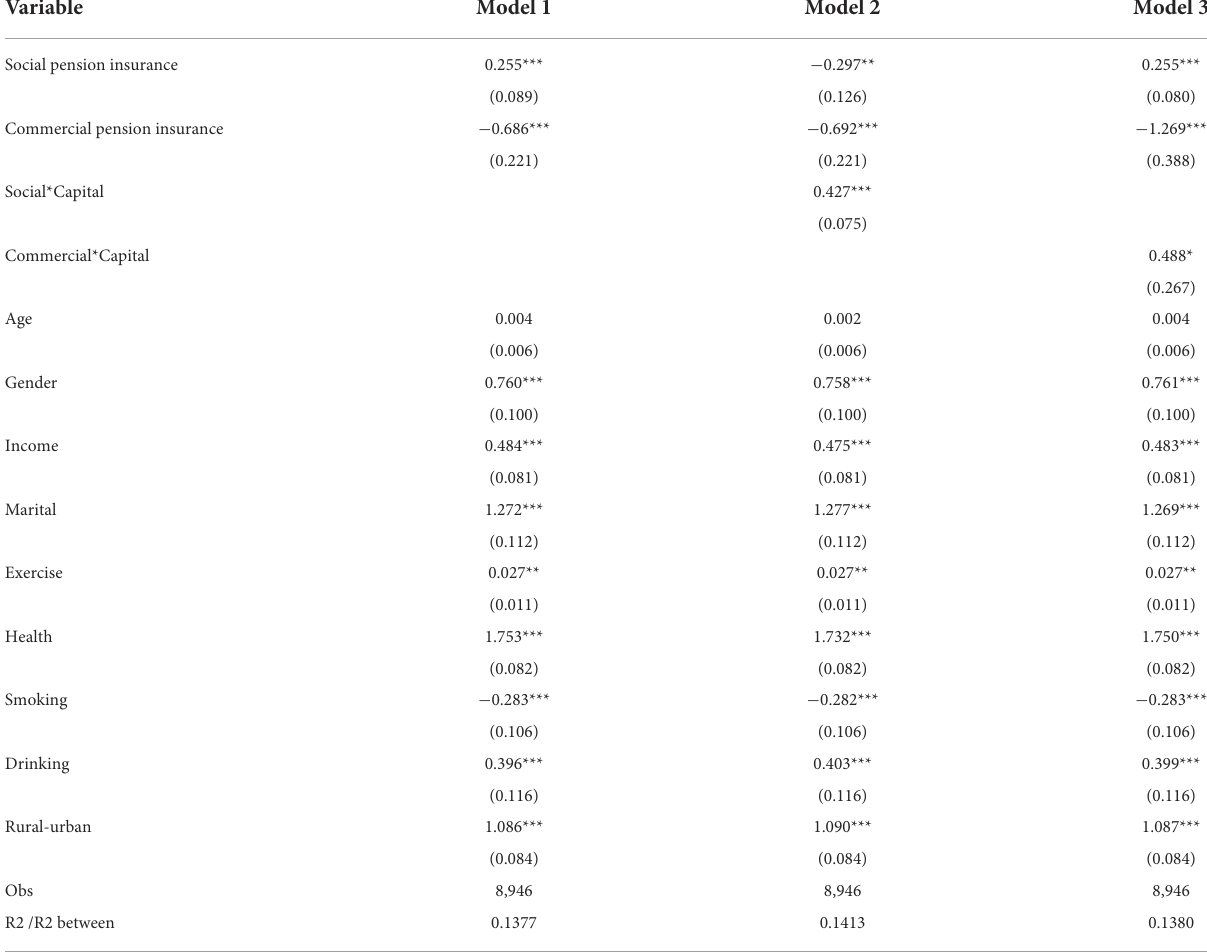
TABLE 6 Regression results of adding missing